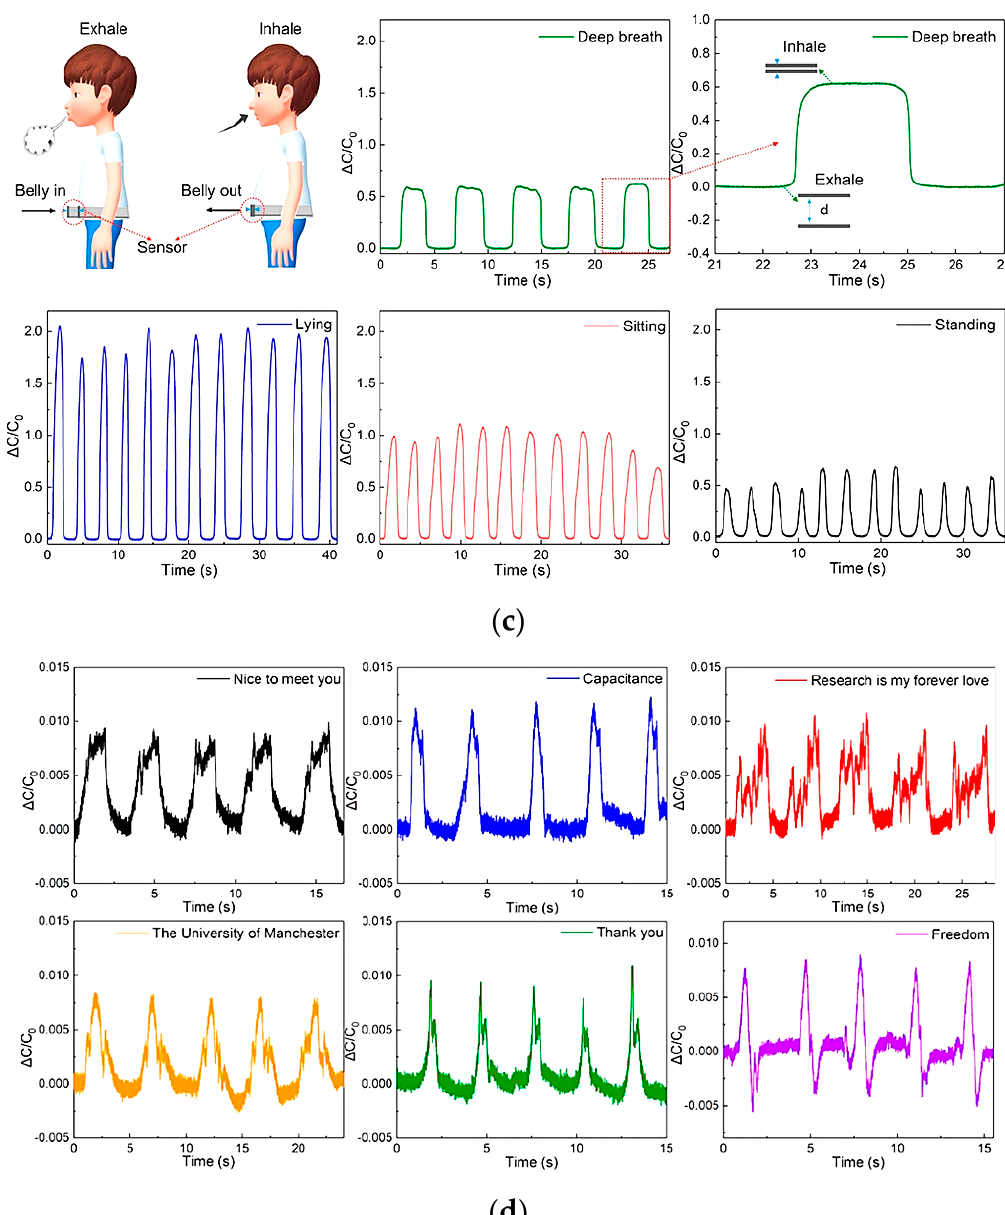
Figure 9. A capacitive pressure sensor’s construction ( a ). Illustration of the ESIM’s (eggshell inner membrane) structural elements ( i ); schematic showing the construction of MXene sheets ( ii ); and the manufacture of flexible capacitive pressure sensors ( iii ). Schematic sensor diagram detecting human physiological signals and body motions. From top left to bottom right: vocal cord vibration signal when pronouncing the word “studying”; capacitance responses from the repeated air blowing, clenching and releasing of finger/knee/elbow bending, and walking ( b ) [29]. Sensor output during exhalation and inhalation acquired as capacitance variation during deep breathing, measured in different positions: standing, sitting, and lying ( c ). Variation in the capacity during the slight vibrations of the vocal cords allowed to recognize “Nice to meet you”, “Capacitance”, “Research is my forever love”, “The University of Manchester”, “Thank you”, and “Freedom” ( d ) [53]. Chen et al. developed a capacitive sensor with a textile structure, excellent conductivity and elasticity, and high comfortability when worn [53]. The sensor was fabricated by coating the starting fabric with nickel. A properly shaped fabric, with a size of 13 mm × 37 mm, was applied to the patient’s belly to evaluate breathing during rehabilitation exercises.